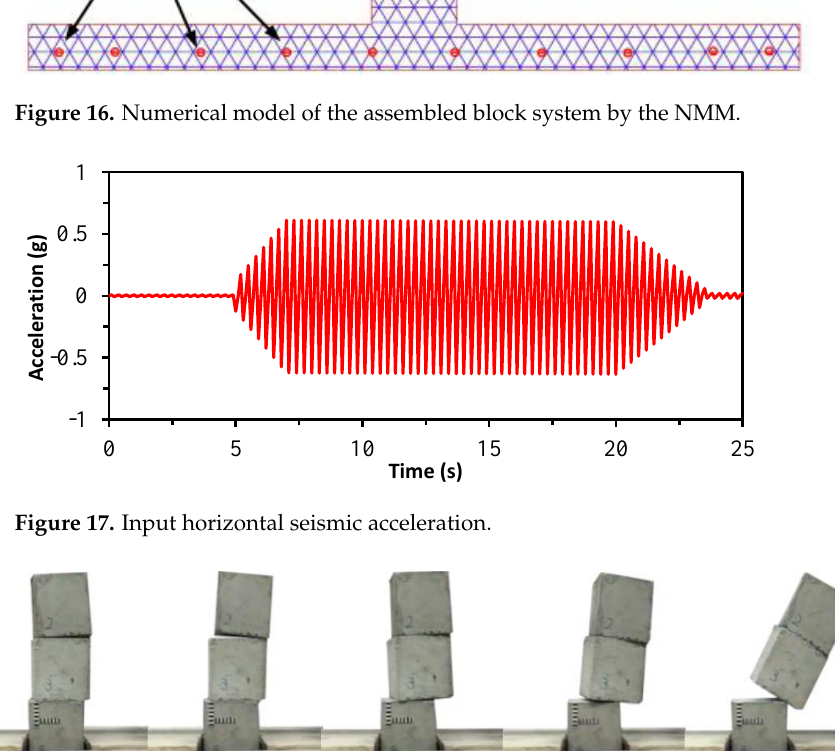
Figure 17. Input horizontal seismic acceleration.